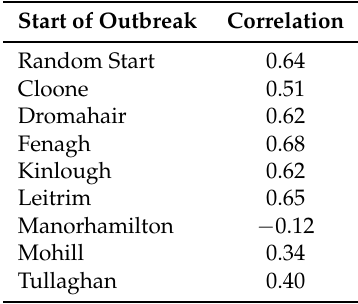
Table 10. Correlations between the percent of runs that lead to an outbreak and the total degree centrality of the town by starting location of the